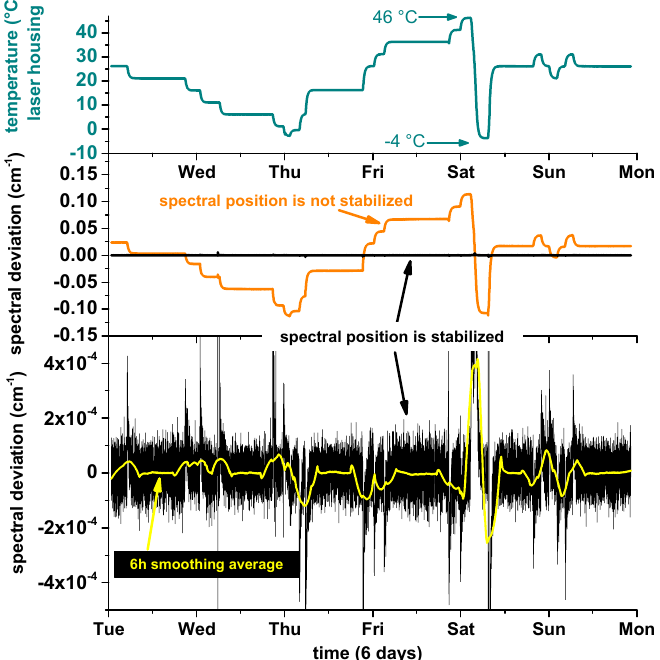
Figure 6. Performance test of spectral stabilization algorithm. The temperature of the spectrometer (top, blue) was variated in an environmental simulation chamber during six days. The black data in the middle subplot show the spectrally stabilized line positions, the orange data show what would have happened if no stabilization had been deployed. The bottom subplot shows a zoomed view on the black data of the middle subplot.